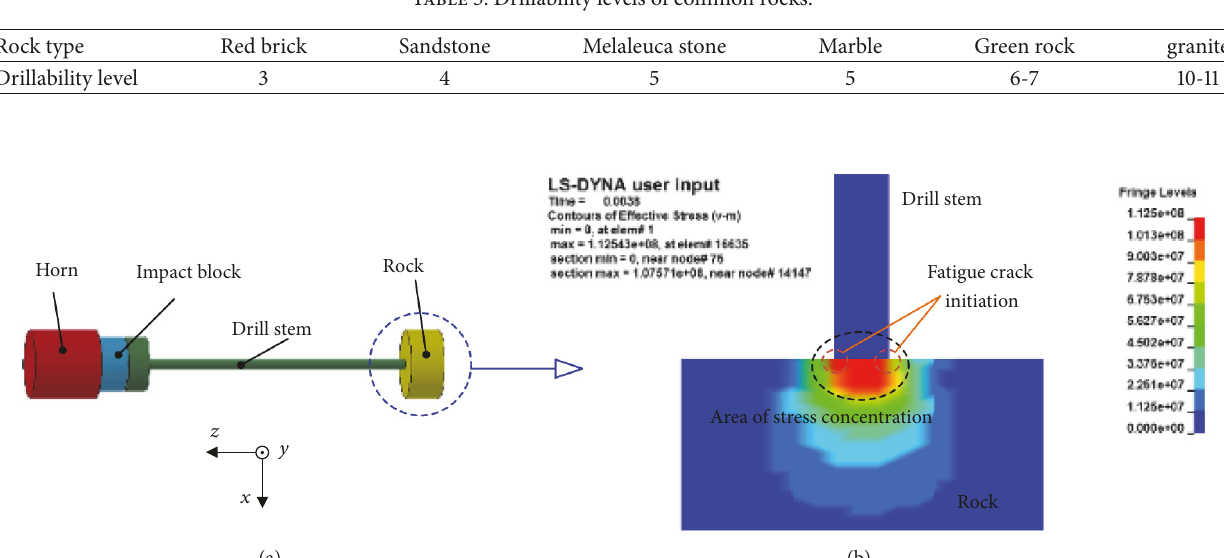
Table 5: Drillability levels of common rocks.